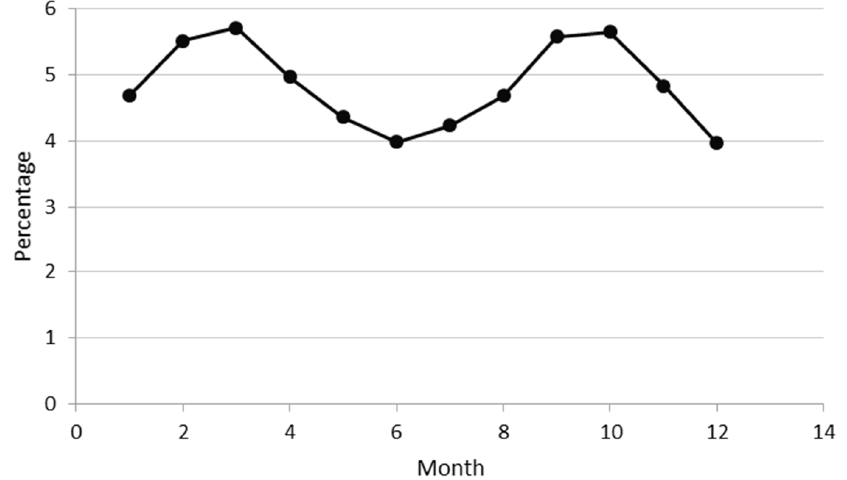
Figure 8. Percentage increase in average monthly solar radiation received for the alternative solar community design.